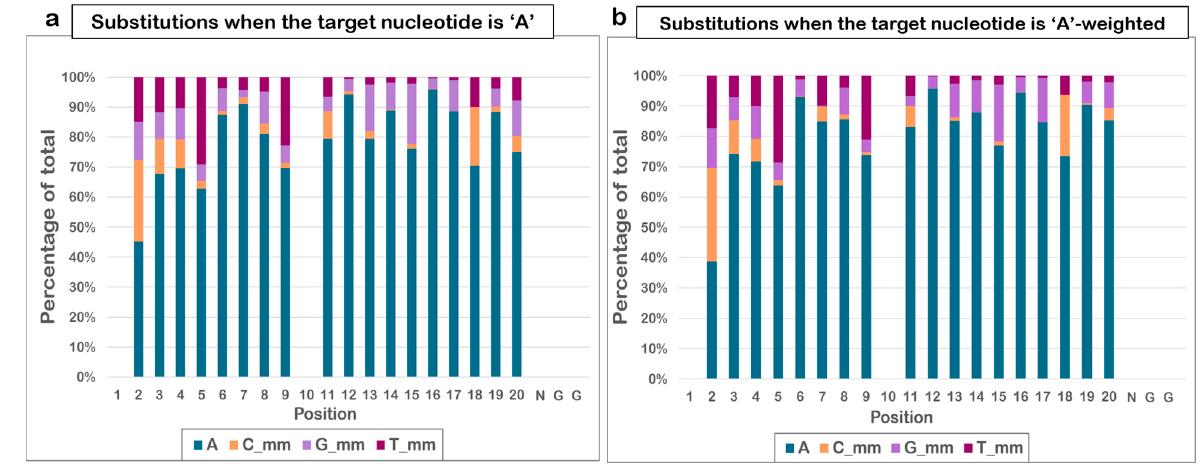
Figure 3. Nucleotide-specific trend in mismatch tolerance. ( a ) Counted for all instances when the target nucleotide is ‘A’ and ( b ) frequency-weighted trend for mismatch tolerance when ‘A’ is the target nucleotide, calculated individually for each position.